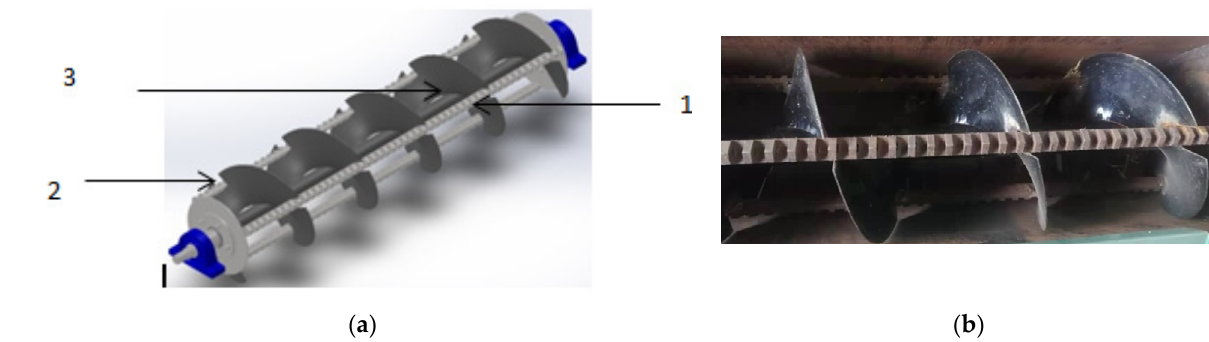
Figure 2. Designed model ( a ) and prototype ( b ) of the threshing roller and the screw conveyor, showing the loop threshing bar (1), the screw conveyor (2) and the main threshing shaft (3).